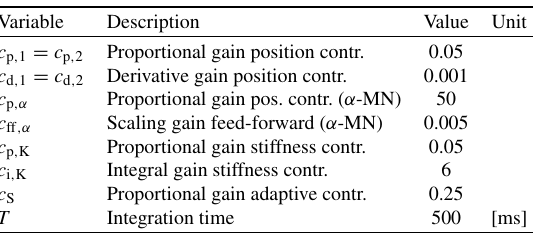
Table 4 Simulation parameters for the bio-inspired control strategy of